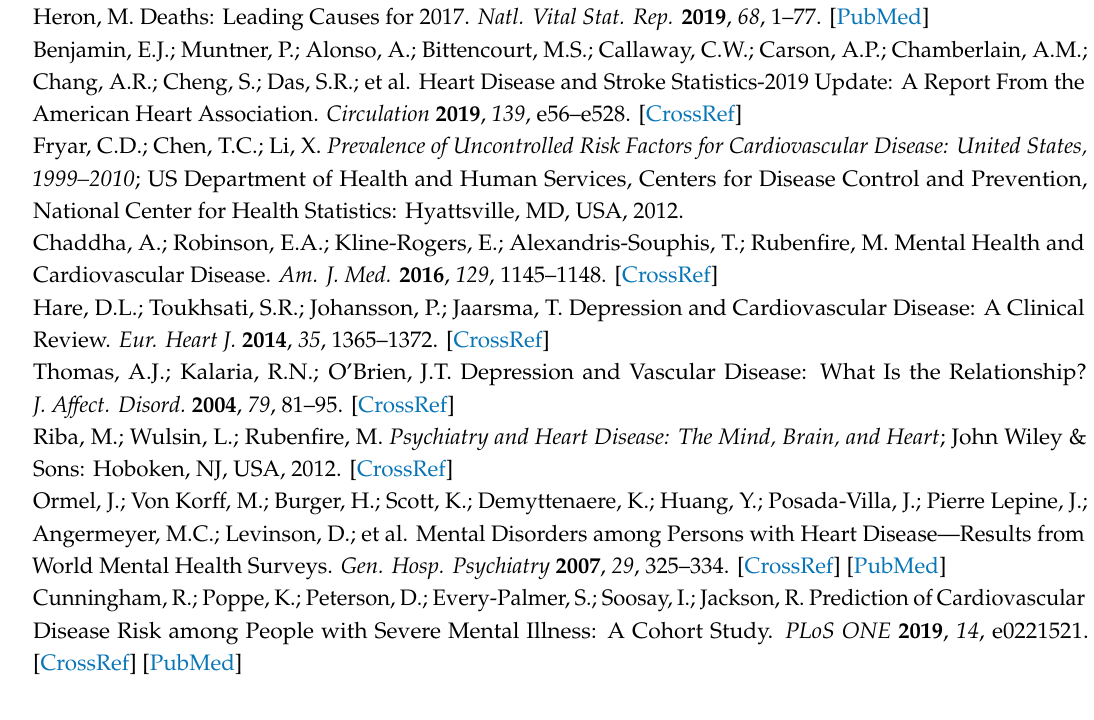
Table S1: Average Metrics of 5-fold CV for the Mental Illnesses with no Variable Selection and no Under Sampling; Table S2: Average Metrics of 5-fold CV for the Mental Illnesses with no Variable Selection and using Under Sampling; Table S3: Average Metrics of 5-fold CV for the Mental Illnesses with Variable Selection using Adjusted R 2 and no Under Sampling; Table S4: Variables Selected using Adjusted R 2 with no Under Sampling; Table S5: Average Metrics of 5-fold CV for the Mental Illnesses with Variable Selection using BIC and no Under Sampling; Table S6: Variables Selected using BIC with no Under Sampling; Table S7: Average Metrics of 5-fold CV for the Mental Illnesses with Variable Selection using Logistic Regression and no Under Sampling; Table S8: Variables Selected using Logistic Regression with no Under Sampling; Table S9: Average Metrics of 5-fold CV for the Mental Illnesses with Variable Selection using Adjusted R 2 and Under Sampling; Table S10: Variables Selected using Adjusted R 2 before Under Sampling; Table S11: Average Metrics of 5-fold CV for the Mental Illnesses with Variable Selection using BIC and Under Sampling; Table S12: Variables Selected using BIC before Under Sampling; Table S13: Average Metrics of 5-fold CV for the Mental Illnesses with Variable Selection using Logistic Regression and Under Sampling; Table S14: Variables Selected using Logistic Regression before Under